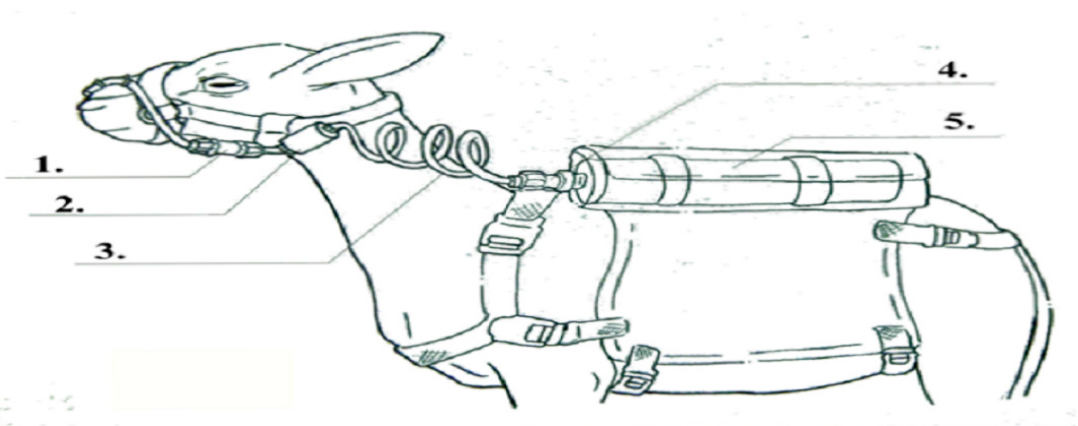
Figure 2. Components of the device used for measuring CH 4 emission. Illustration of components to collect CH 4 : 1. Flow control valve; 2. particle filter; 3. spiral hose; 4. quick connect; 5. stainless cylinder.